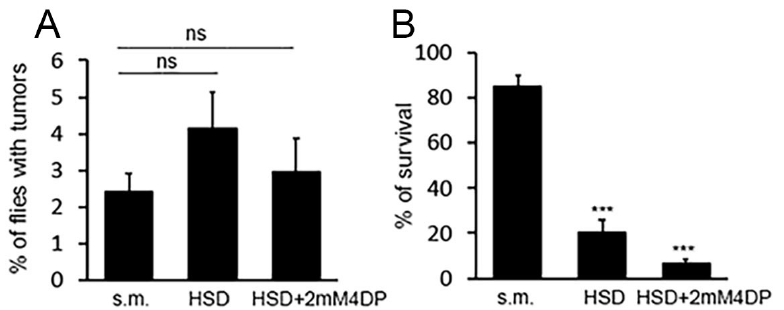
Figure 4. Effect of the combined treatment HSD + 4DP on LOH at the wts locus . ( A ) Quantification of tumors in wts/+ flies reared in the indicated media. For each condition, more than 500 flies were examined in three different experiments. Each column represents the mean value ± SEM. ( B ) Percentage of flies that reach the adult stage. Each column represents the mean value ± SEM obtained by examining about 500 flies per condition in three different experiments. s.m. = standard medium HSD = high sugar diet; 4DP = 4 deoxypyridoxine; ns = non-significant Chi-square test. *** Significantly different in Chi-square test, with p <